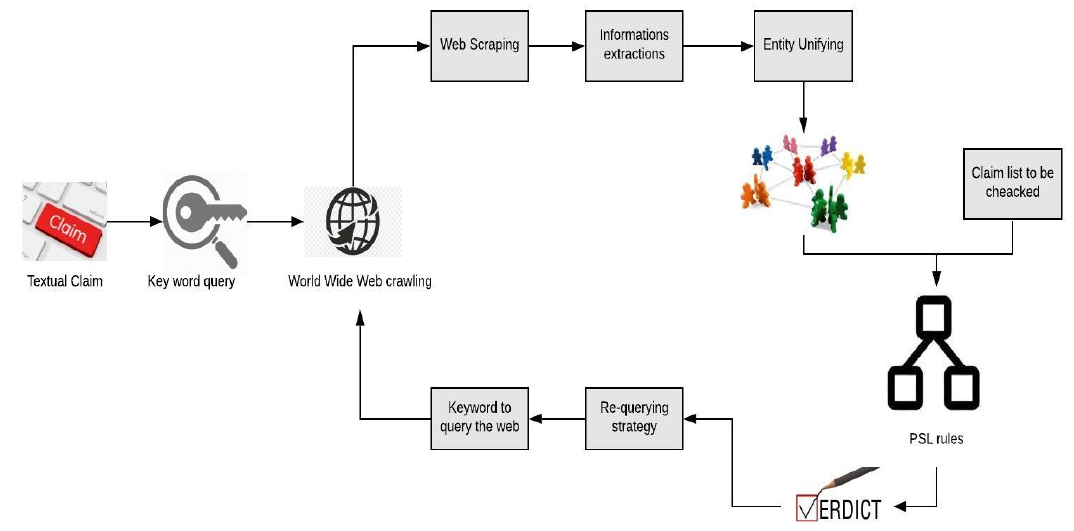
Figure 2. Facts Automatic Consistency Test (FACT)